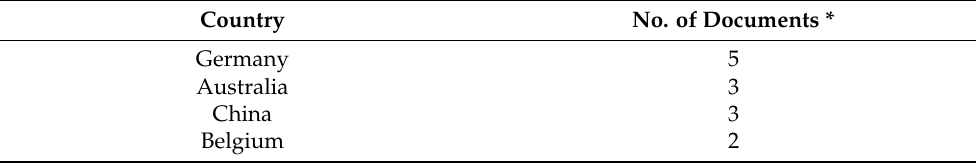
Table 2. Cont. Country No. of Documents *